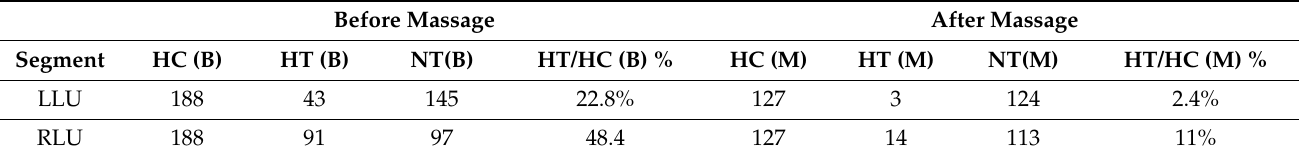
Table 2. Change in the number of hypertonic cycles before and after